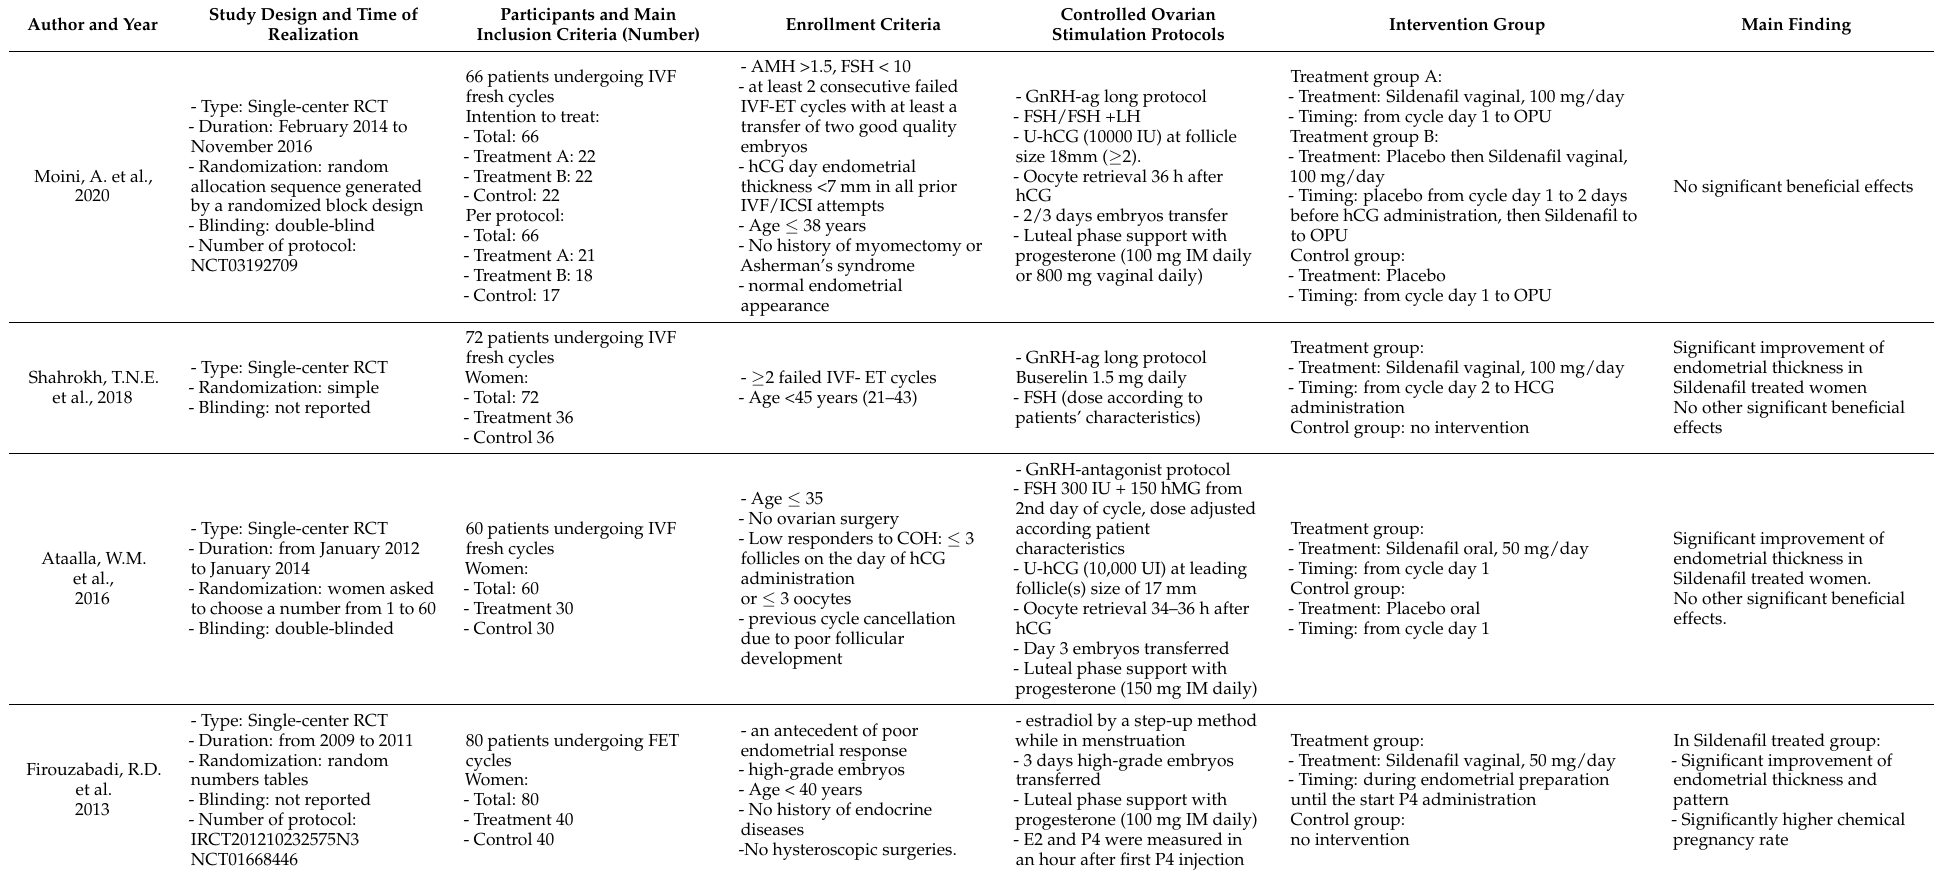
Table 2. Data about general features of the manuscripts evaluated in this systematic review and meta-analysis including the dose and the days of Sildenafil treatment in IVF fresh and frozen embryo transfer